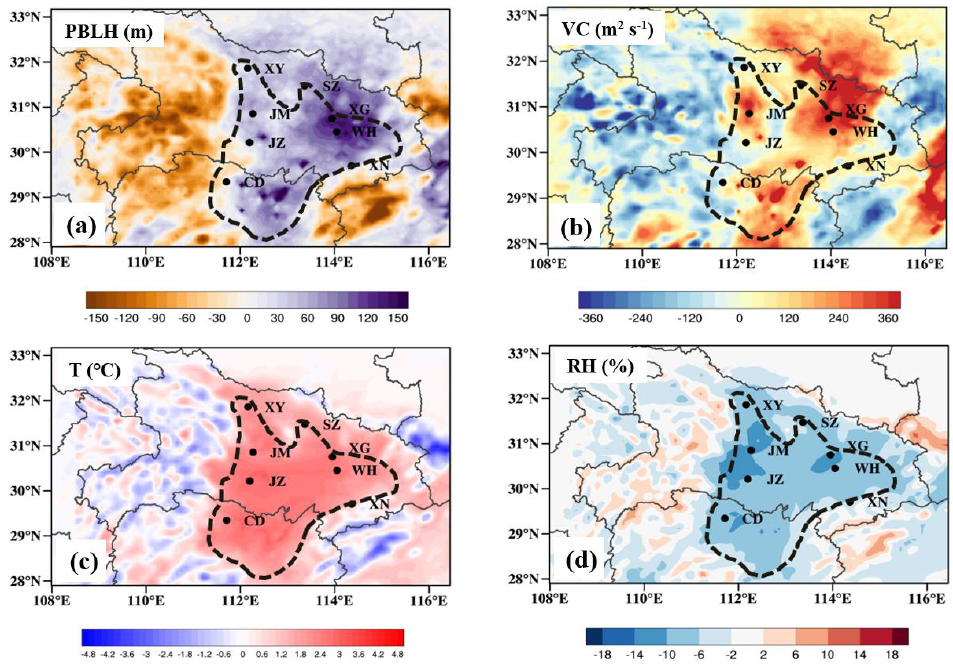
Figure 7. Near-surface di ff erences of ( a ) planetary boundary layer height (PBLH; m), ( b ) ventilation coe ffi cient (VC; m 2 s − 1 ), ( c ) air temperature (T; ◦ C), and ( d ) relative humidity (RH; %) between real terrain (E1) and changed terrain (E3)